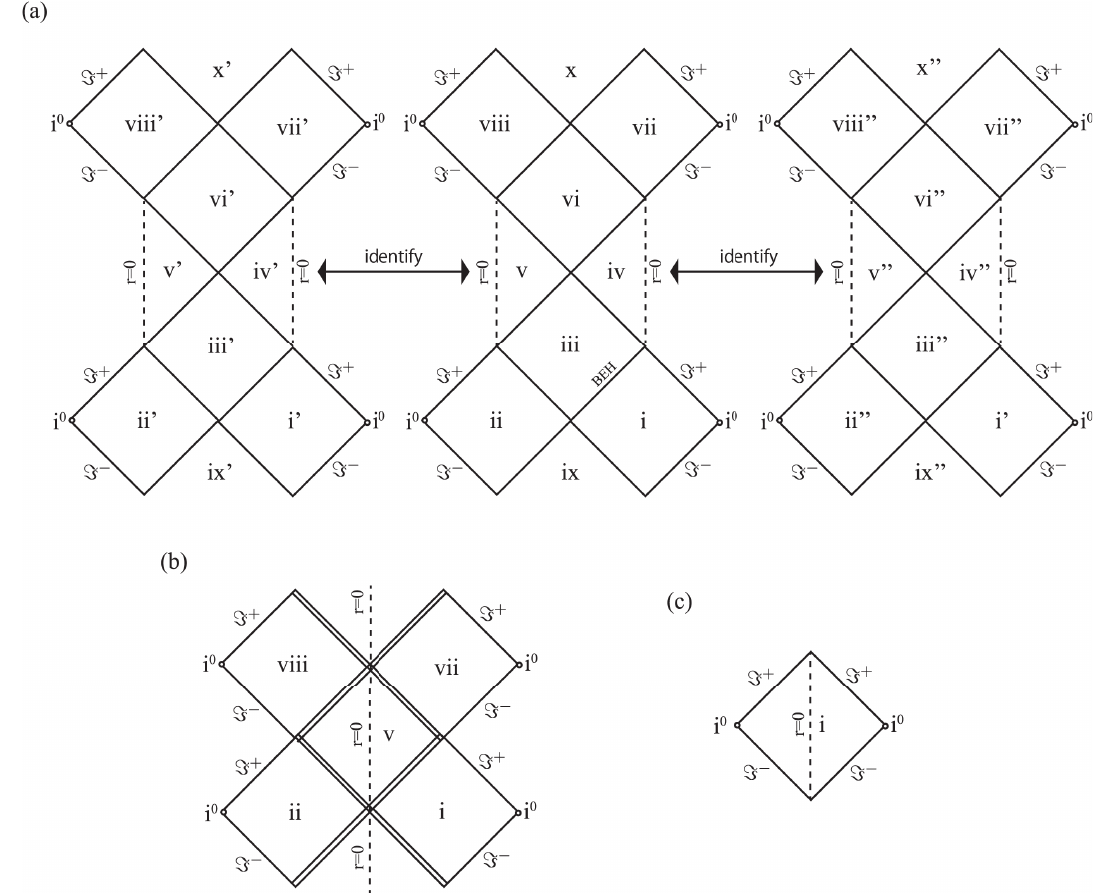
Figure 6 . Penrose diagrams of the rotating Dymnikova black hole with (a) non-degenerate horizons ( m > m ), (b) degenerate horizons ( m = m ex at ( r, θ ) = (0 , π/ 2) is not a scalar polynomial curvature